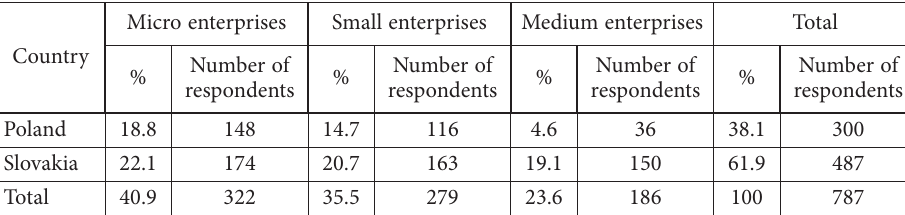
Table 1. Structure of Polish and Slovak